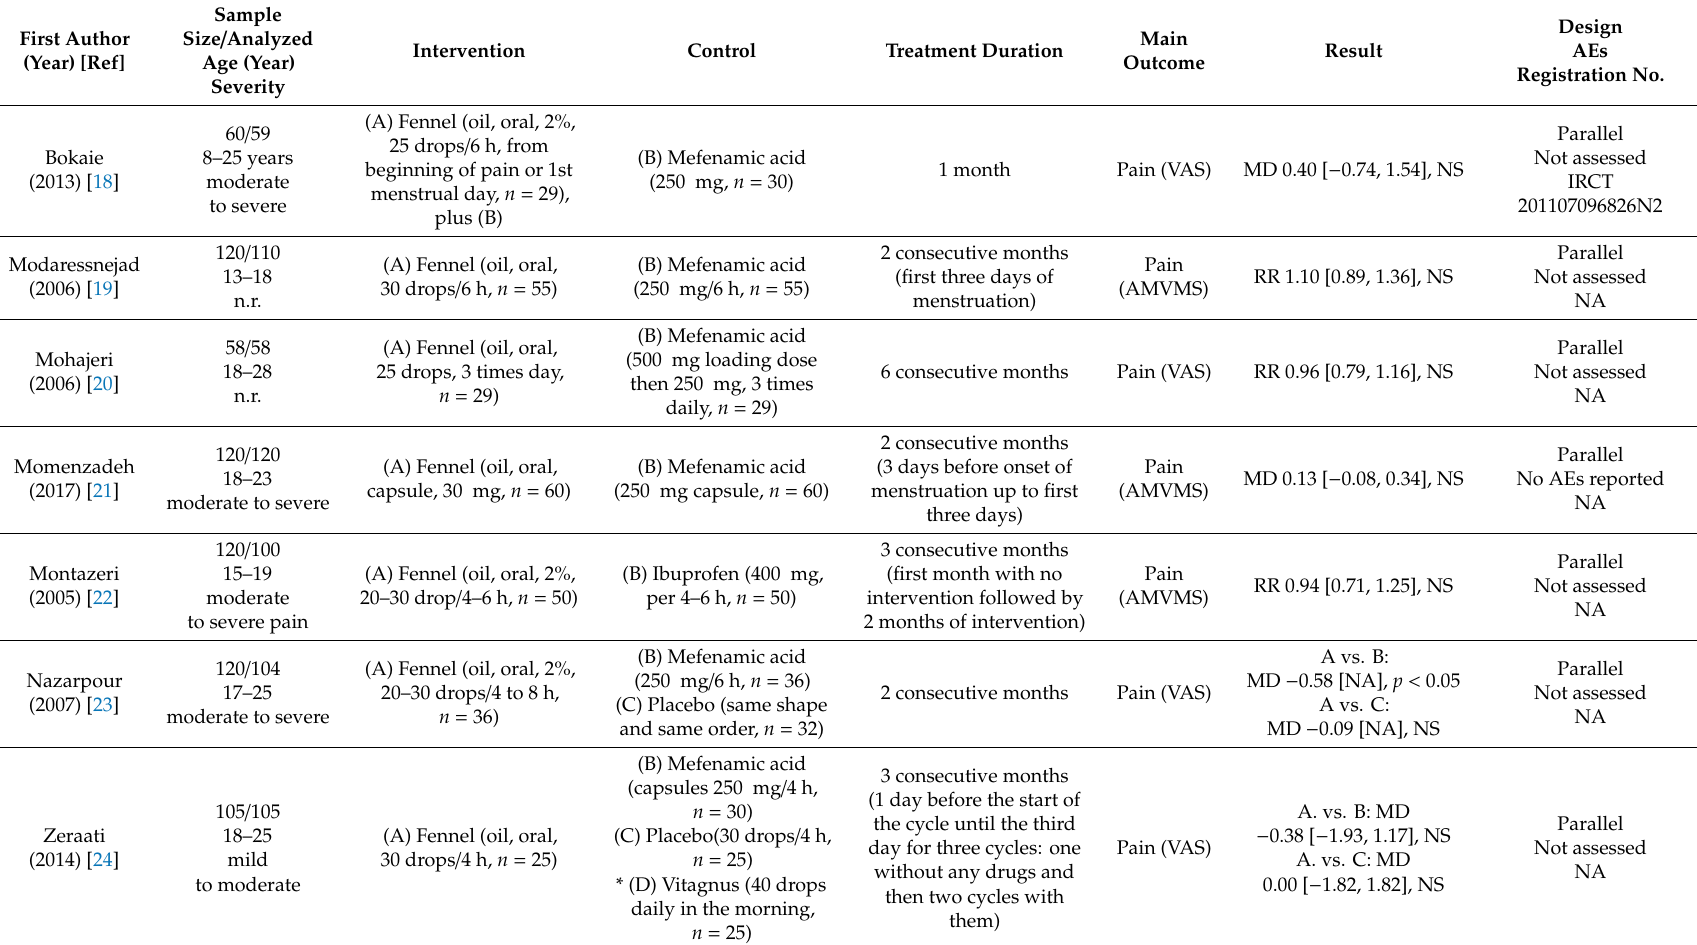
Table 1. Summary of randomized clinical trials of fennel for